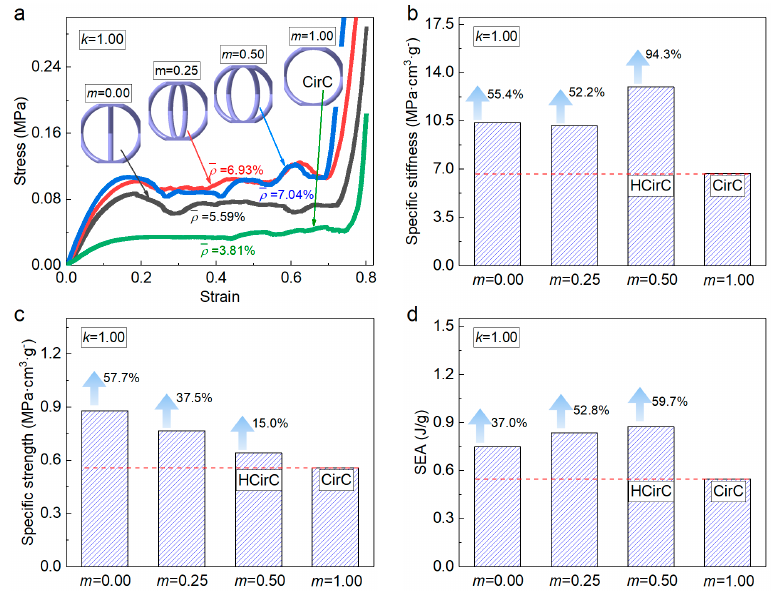
Figure 16. Effect of parameter m on the mechanical performance of the hierarchical lattice structure HCirC: ( a ) stress–strain curves; ( b ) specific stiffness; ( c ) specific strength; ( d ) SEA.